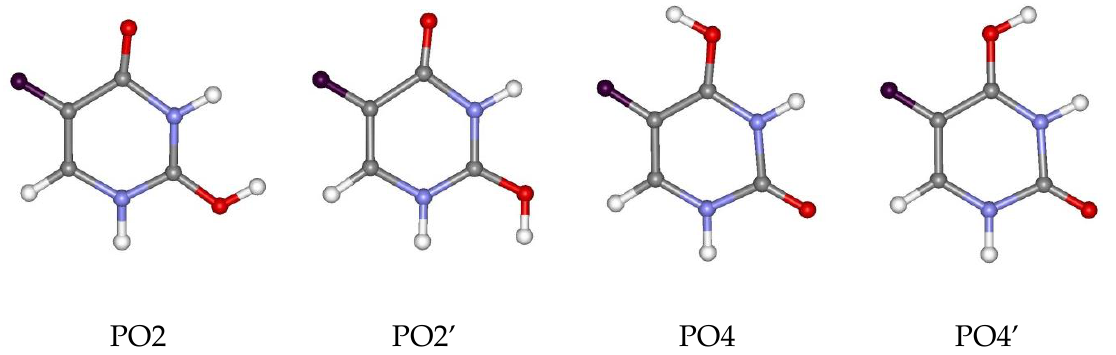
Figure 2. Optimised protonated forms of 5FU with different hydrogen orientations.